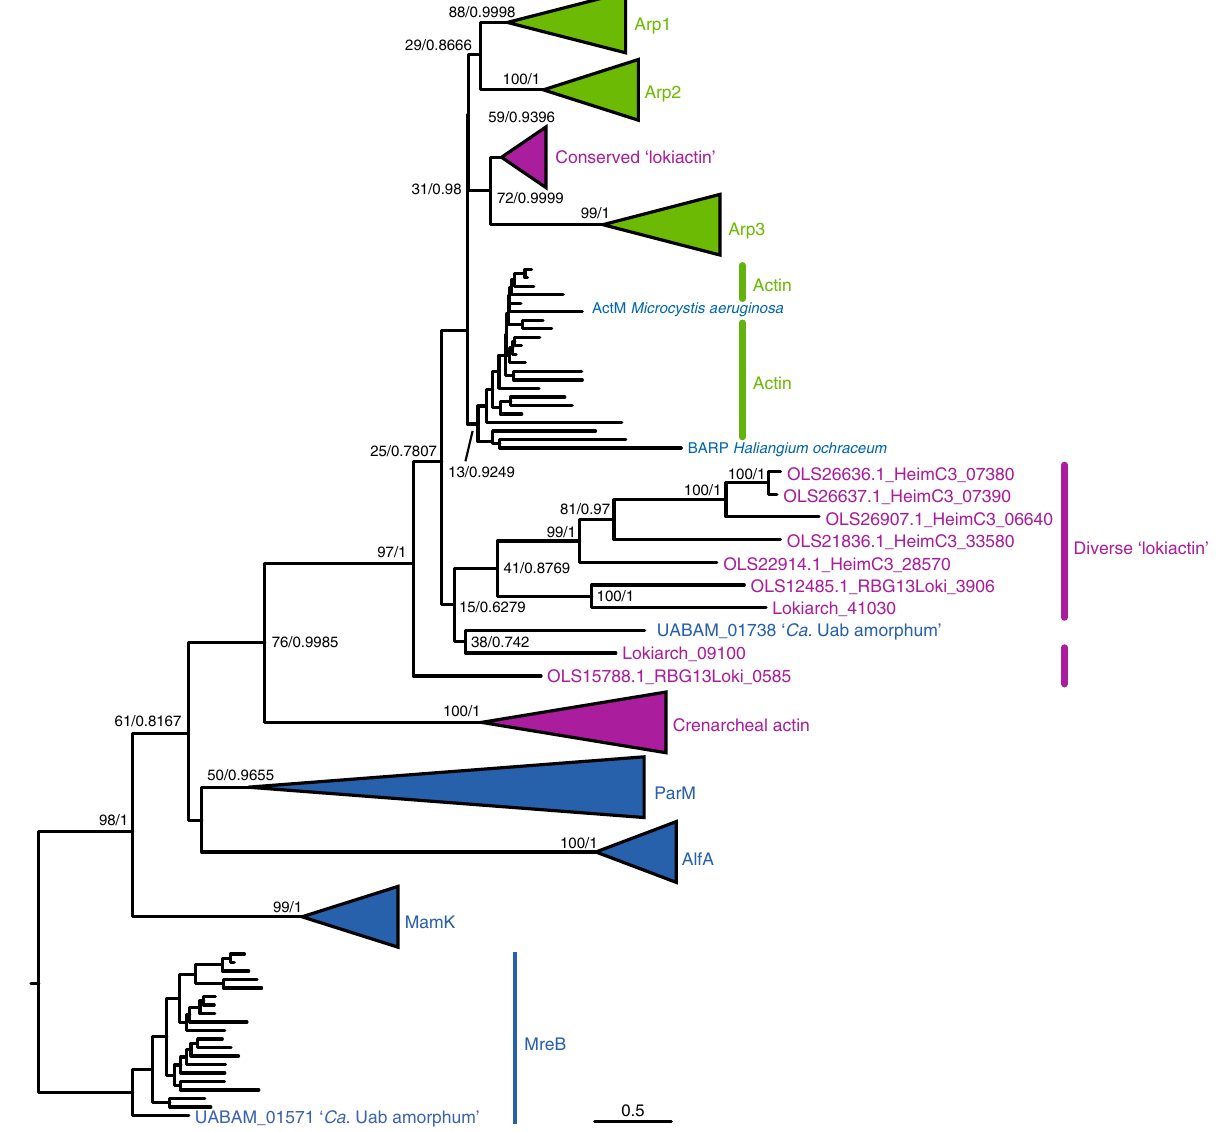
Fig. 6 Maximum likelihood tree of actin-like proteins. Left and right values on nodes indicate bootstrap value and Bayesian posterior probability, respectively. Bacterial actin-related protein (BARP) of Haliangium ochraceum and ActM of Microcystis aeruginosa form a clade with eukaryotic actin. Scale bar indicates amino acid substitution rate per